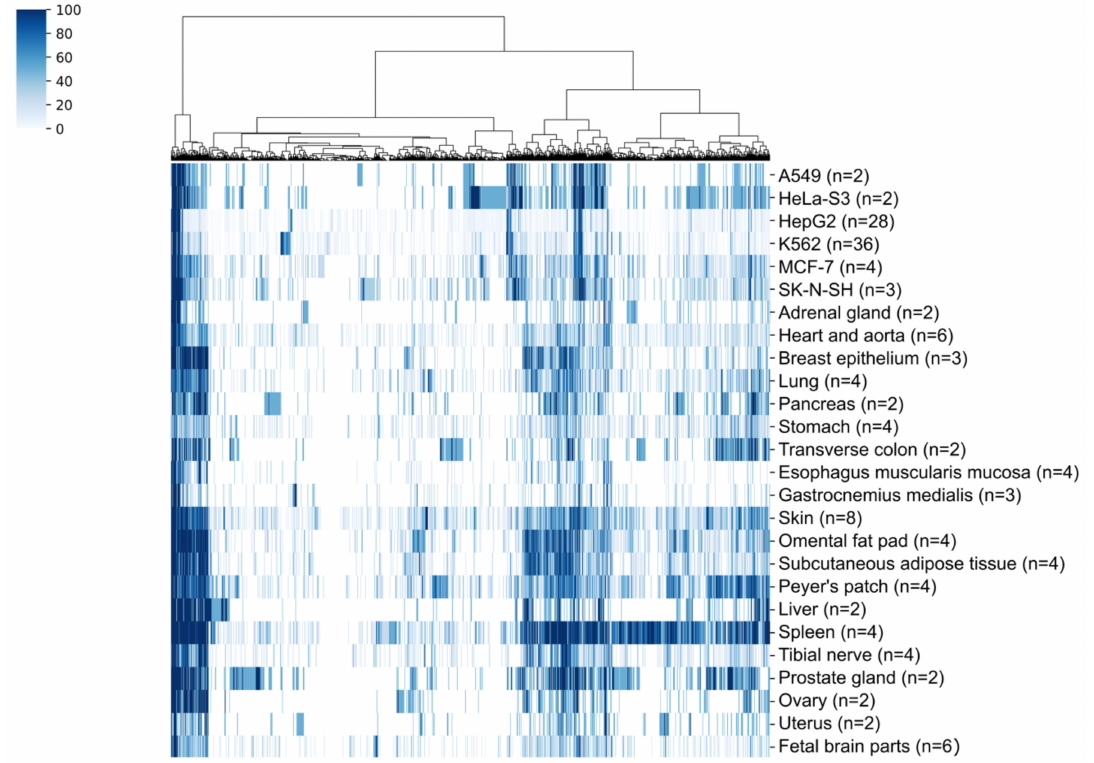
Figure 3. Percentage of samples from normal tissues and cancer lines in which retrocopies are expressed. A very dark blue color indicates that a given retrocopy is expressed in all samples of a particular